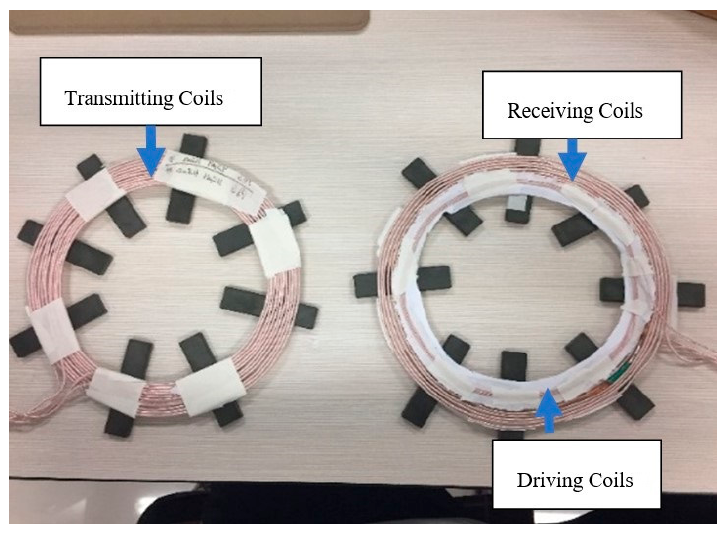
Figure 13. Experimental platform.